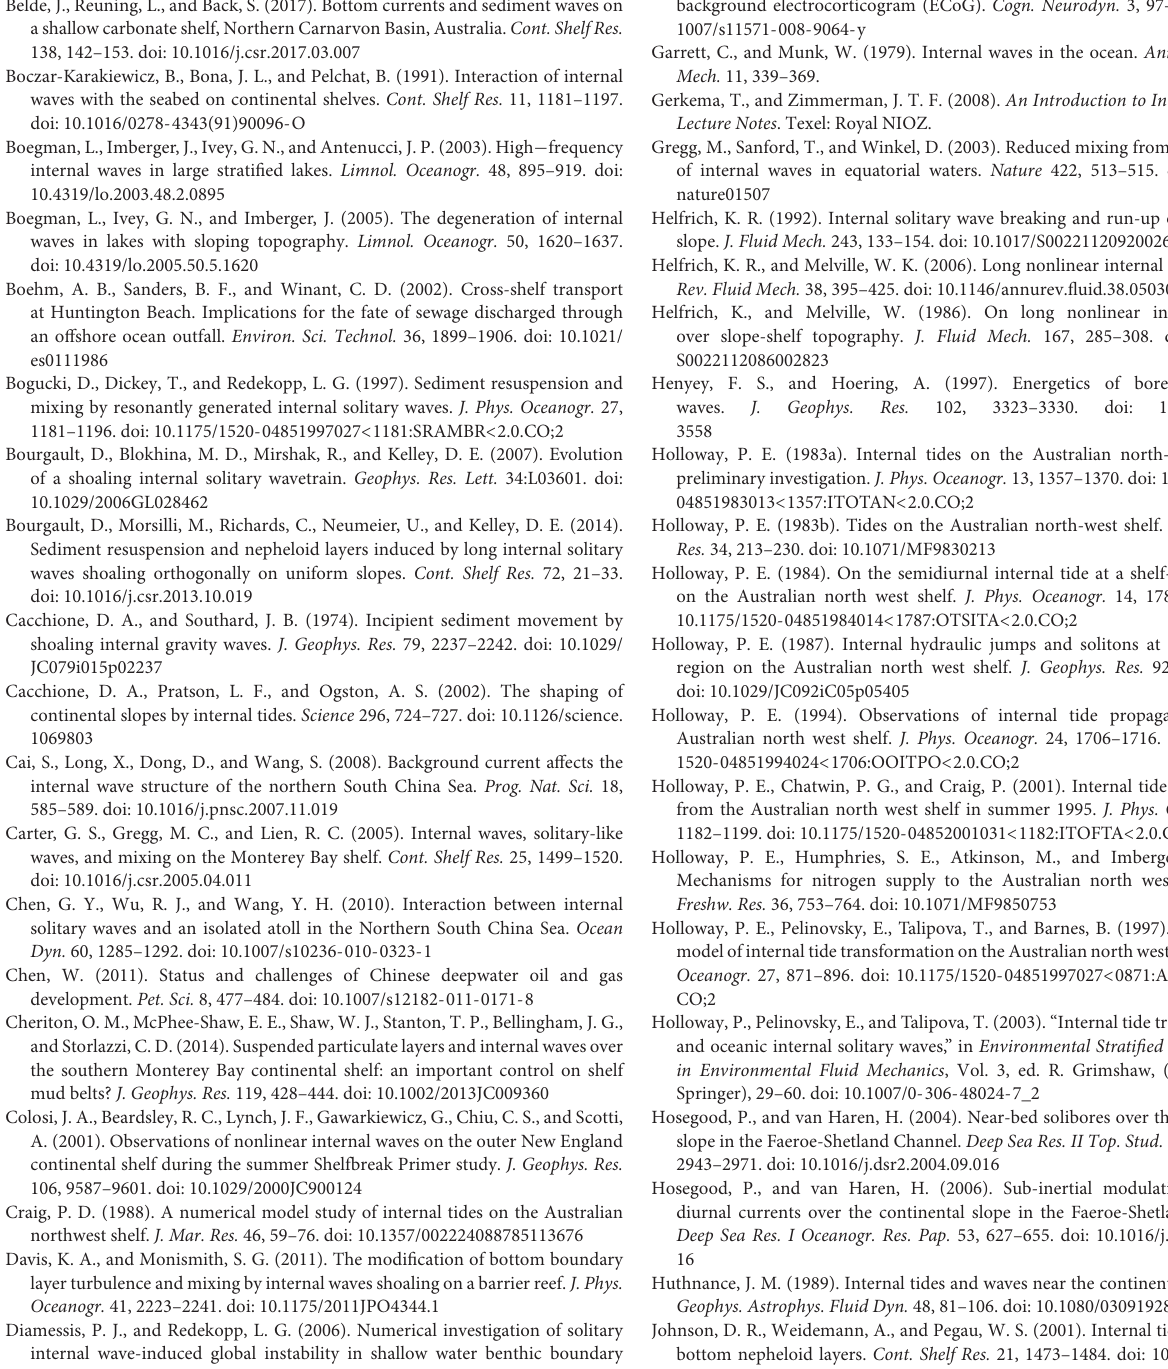
bottom nepheloid layers. Cont. Shelf Res. 21, 1473–1484. doi: 10.1016/S0278-